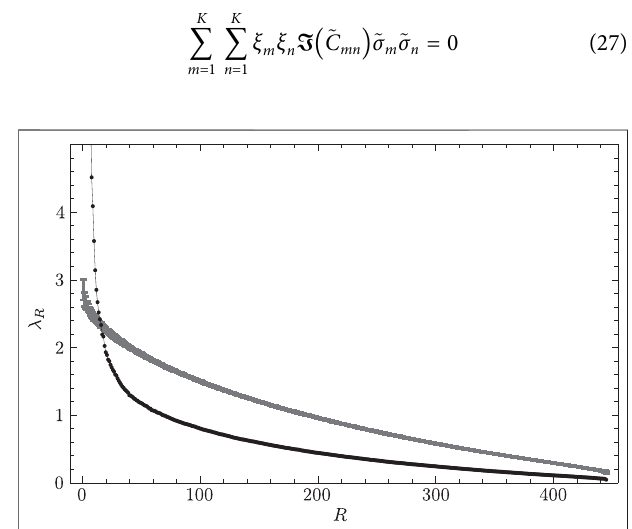
FIGURE 9 | Scree graph of eigenvalues. The abscissa represents eigenvalue rankings R , while the ordinate represents empirically obtained eigenvalues λ R . The curve with error bars in this fi gure shows the eigenvalue distribution of the RRS complex correlation matrix. To obtain this curve, this manipulation was repeated 20 times, after which the mean value and standard deviation were calculated. Each error bar represents three times the standard deviation. The thin line with fi lled circles in this fi gure depicts the distributionofeigenvaluesoftheempiricalequal-timecross-correlationmatrix. The meaningful part can be obtained by comparing these two distributions. If the upper bound for eigenvalues derived from the RRS cross-correlation matrix is denoted as λ max , then λ 1 > λ 2 > ... > λ 16 > λ max (cid:2) 2 . 18894. Hence, 16 meaningful components should be retained for this